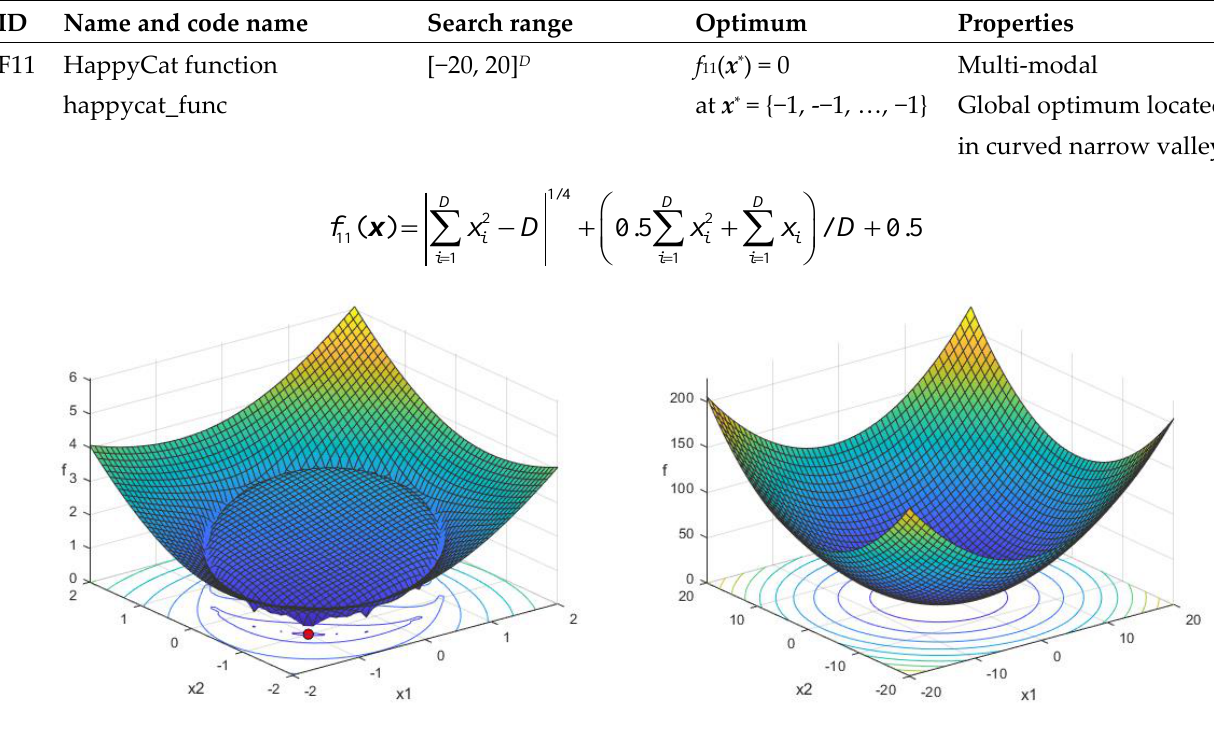
Figure A11. HappyCat function in two dimensions.